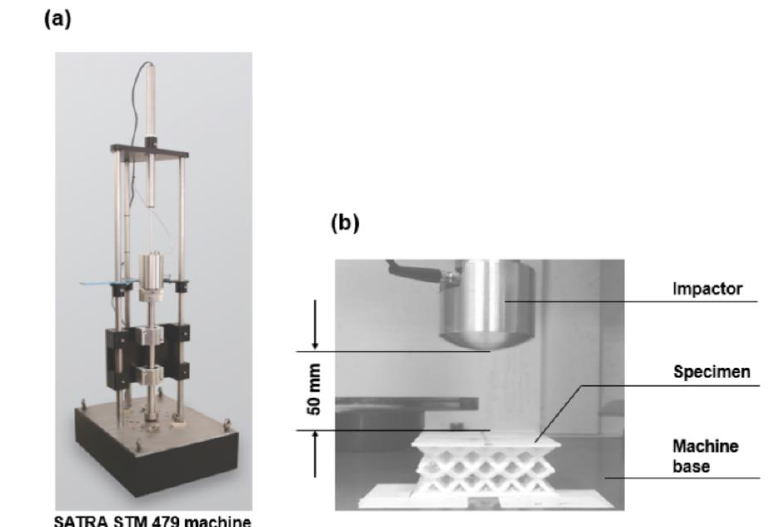
Figure 6. ( a ) The TPU 95A specimens of sandwich structures with six types of lattice core fabricated by ( b ) FDM manufacturing technique.